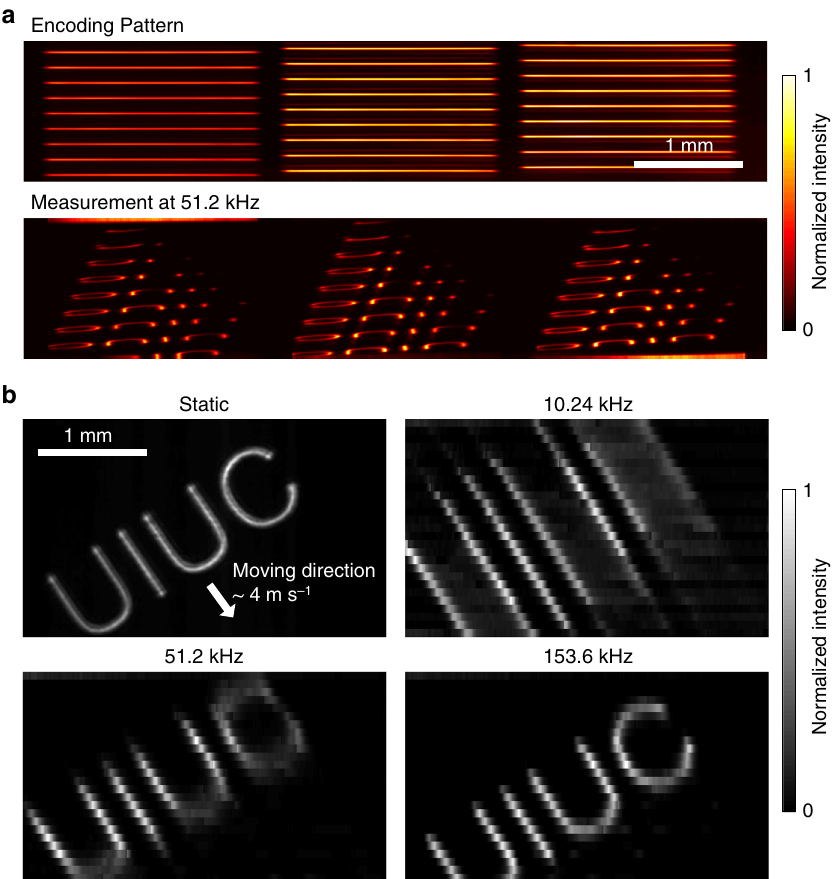
Fig. 5 ( x , y , t ) imaging through direct optical mapping. a An incident image is horizontally sliced by the active optical mapper and temporally sheared by the TDI camera. b Captured images at various frame